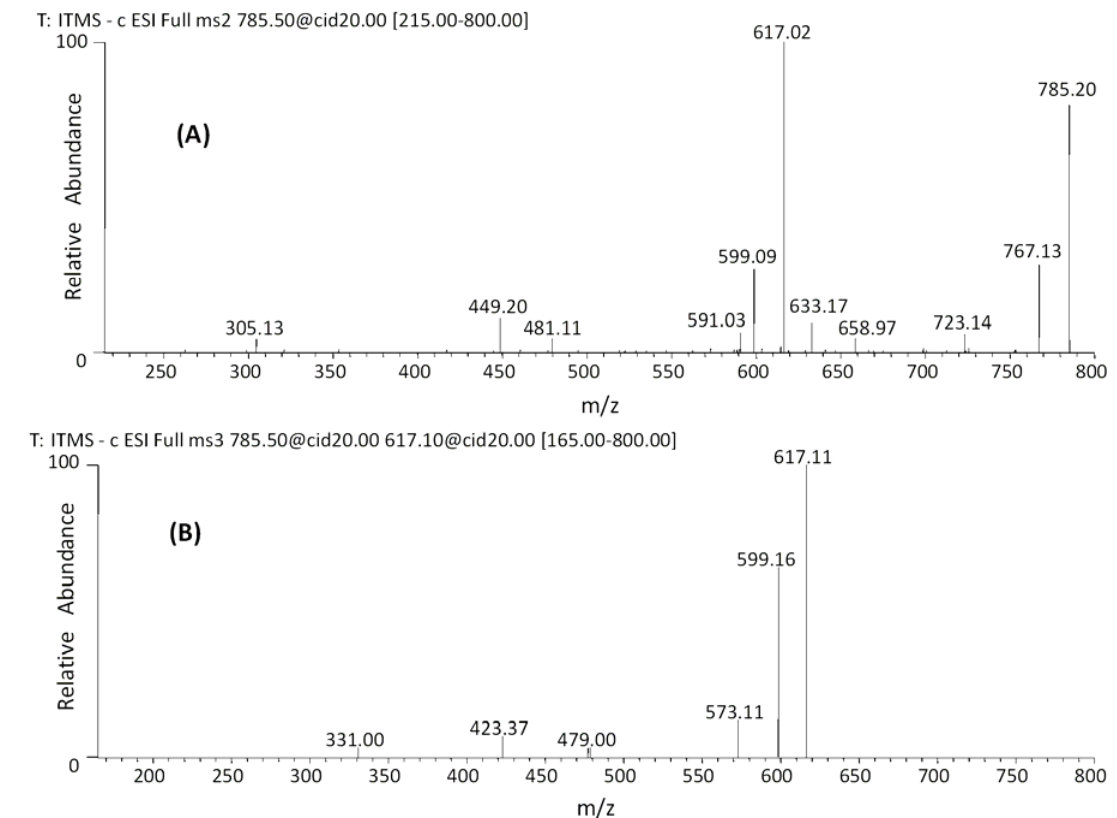
Figure 2. Negative ion ESI-MS n spectra of B-type dimer. ( A ) MS 2 of m/z 785 [M − H] − and ( B ) MS 3 of m/z 617 [M − H] −